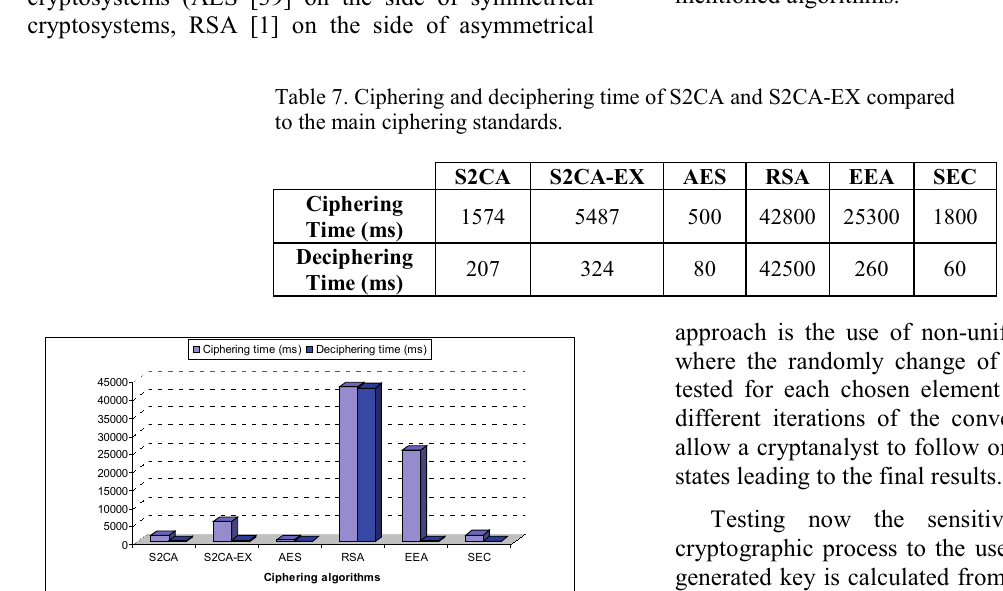
Fig. 14. Ciphering and deciphering time of S2CA and S2CA-EX compared to the main ciphering